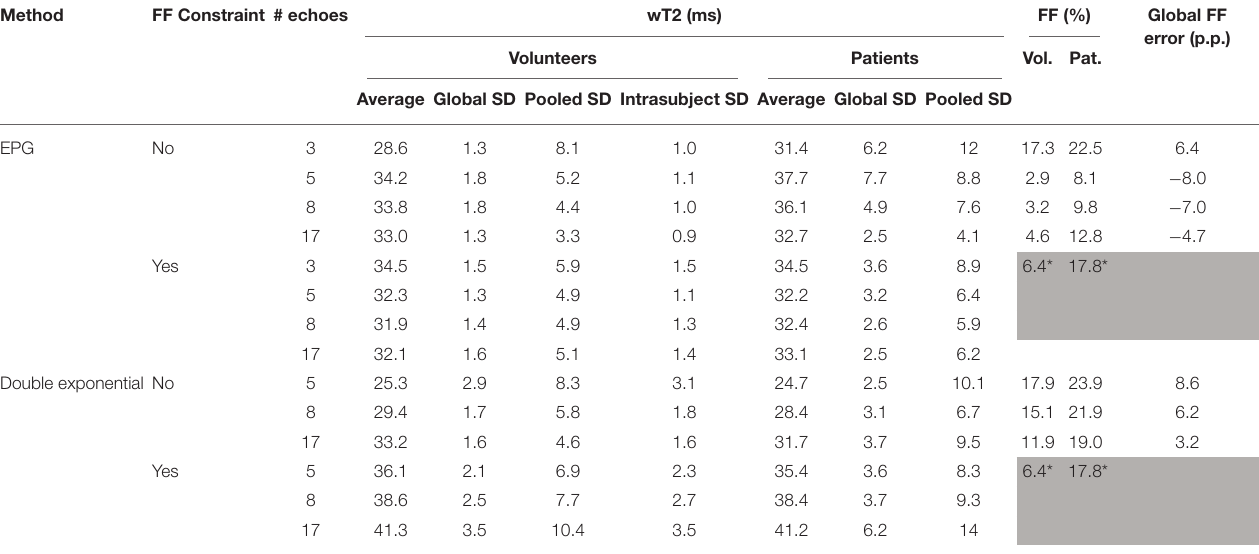
TABLE 2 | Summary of results for the different fitting methods, with and without an external proton-density-weighted fat fraction (FF) constraint.